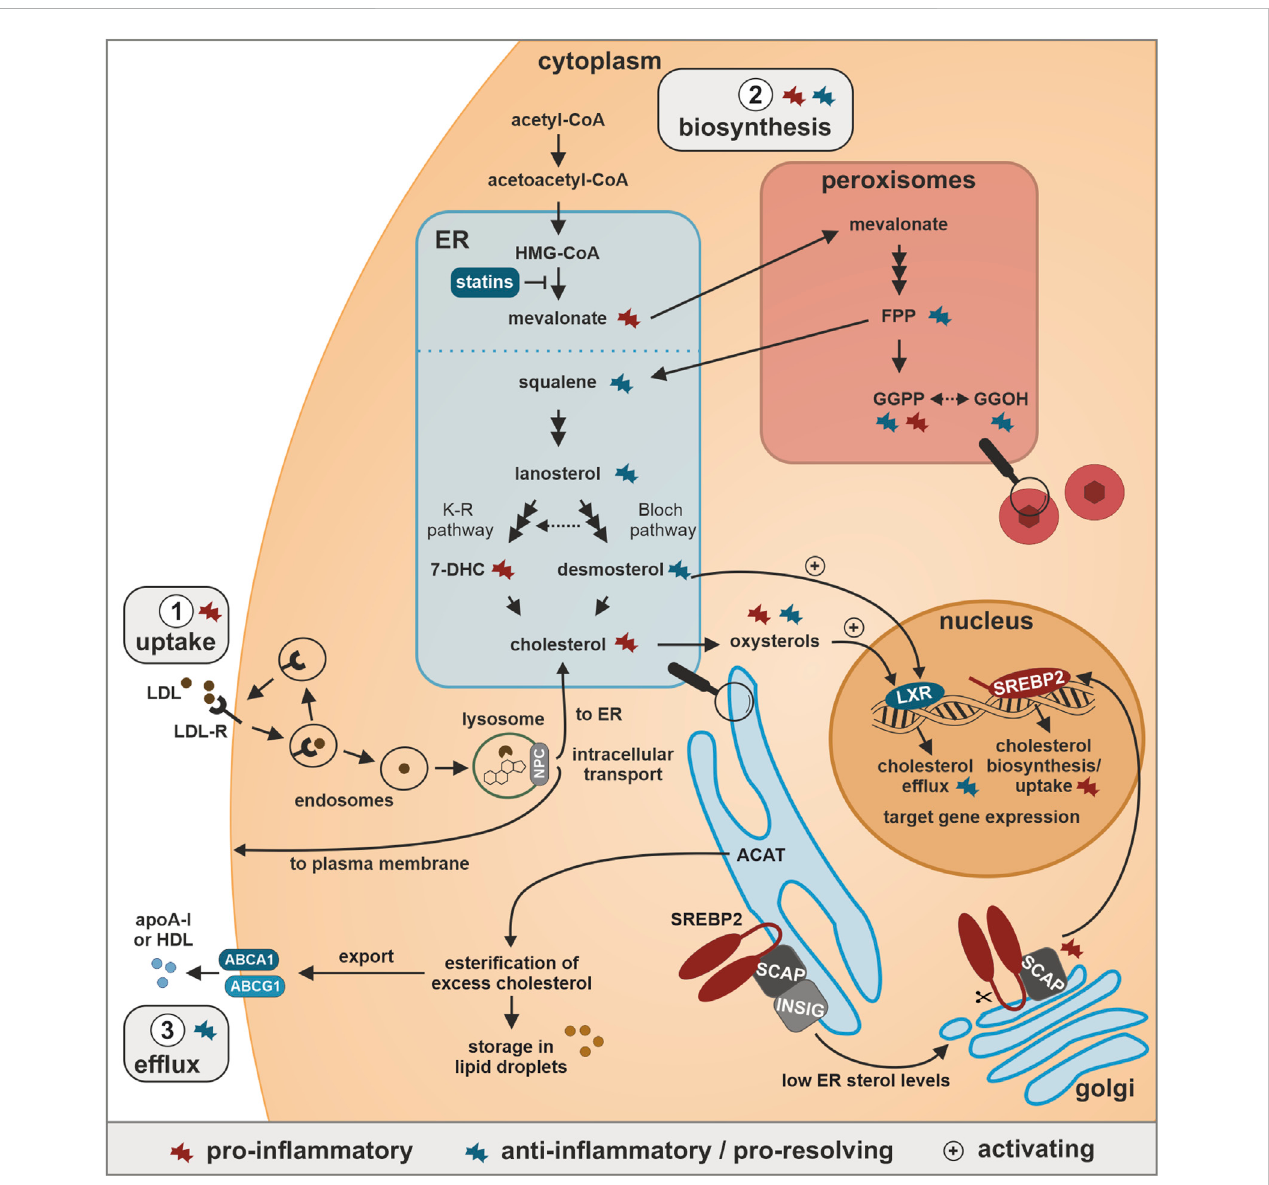
Cholesterol homeostasis and in fl ammatory regulation. 1. Uptake: Cholesterol is taken up bound to low-density lipoprotein (LDL) particles via LDL- receptor (LDL-R)-associated endocytosis, released from LDL upon fusion of endosomes with lysosomes, and distributed by Niemann-Pick type C (NPC) proteins to either the endoplasmic reticulum (ER) or the plasma membrane. 2. Biosynthesis: Cholesterol is synthesized starting from acetyl-CoA in the cytoplasm, converted via 3-hydroxy-3-methylglutaryl-coenzyme A (HMG-CoA) to mevalonate in the ER, further processed in peroxisomes to the isoprenoids farnesyl pyrophosphate (FPP) and geranylgeranylpyrophosphate (GGPP), which can also beproducedfromtheGGPP-precursor geranylgeraniol (GGOH). In the ER, two FPP molecules condensate to squalene, which in a multi-step process is processed to lanosterol, which is further metabolized in the parallel Bloch and Kandutsch-Russel (K-R) pathways to desmosterol and 7-dehydrocholesterol (7-DHC), respectively, both of which are direct precursors of cholesterol. ER cholesterol levels are sensed by sterol response element-binding protein 2 (SREBP2), which is bound by SREBP cleavage-activating protein (SCAP) and insulin-induced gene (INSIG) in the ER. Low ER cholesterol levels induce translocation of SCAP-bound SREBP2 to the Golgi, where it undergoes cleavage-dependent activation.TheN-terminal SREBP2 fragment actsastranscriptionfactoramongothersfor cholesterol biosynthesisenzymesandLDL-R. 3. Ef fl ux: Excess cholesterol in the ER is esteri fi ed by acyl coenzyme A:cholesterol acyltransferase (ACAT) and subsequently either stored in lipid droplets or exported via ATP-binding cassette A1 (ABCA1) or ABCG1 and loaded onto high-density lipoprotein (HDL) and apolipoprotein A-I (apoA-I) for retrograde transport to the liver. Elevated oxysterol and desmosterol levels further activate the transcription factor liver X receptor (LXR) to enhance the expression of cholesterol